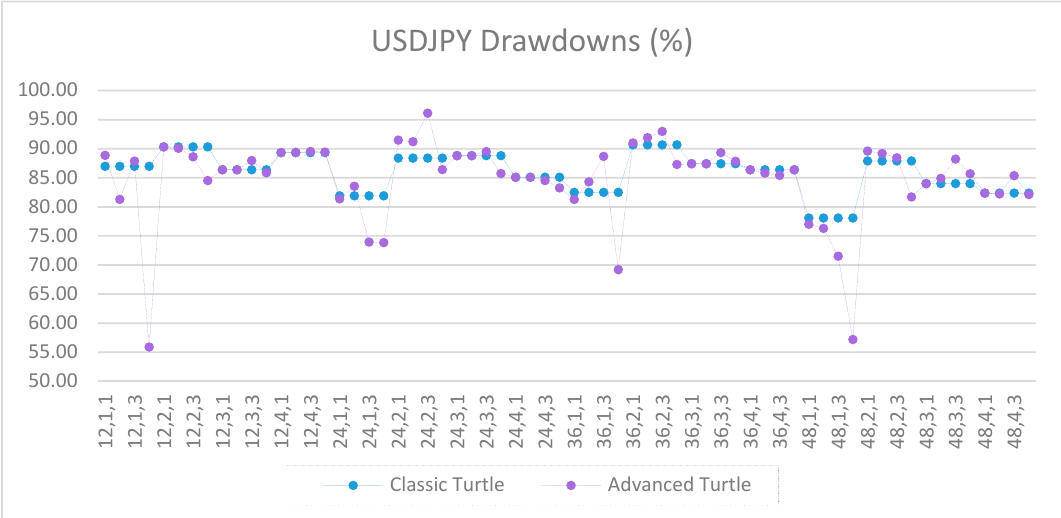
Figure A41. Net profits of USDJPY between the classic and the advanced Turtle systems for every combination of N, X, Y for the slow parameters (80, 160).